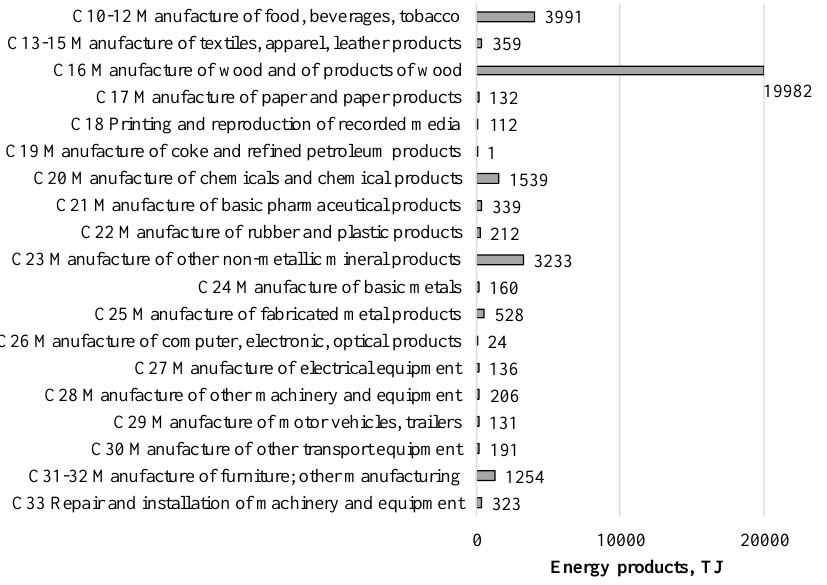
Fig. 1. Physical energy flow accounts for the use of energy resources in manufacturing subsectors 2016 (CSB: ENG200). Considering the implementation of energy efficiency measures, some significant differences are distinguished between energy intensive and non-intensive industries. For example, energy efficiency can be examined at the overall industry sector or in separate sectors, such as energy-intensive companies or separate key areas [13]. A significant problem for the generalized definition of energy intensive industries is the differences in industrial portfolio of various countries. For example, commonly metal industry (C24) and non-metal mineral industry (C23) are considered energy intensive industries, but for Latvia’s case the specific energy costs attributed to total value of production for these industries constitute only half in comparison with C16 and C33 (Fig.